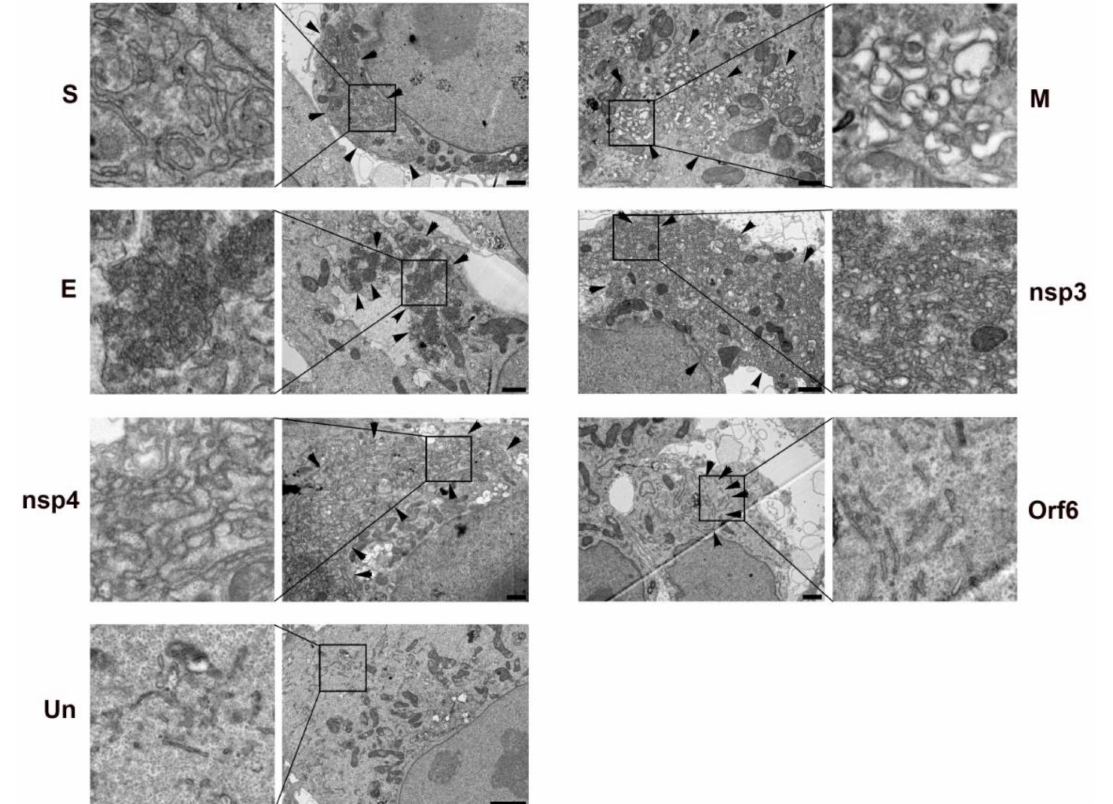
Figure 10. Correlative Light and Electron Microscopy (CLEM) to examine the ultrastructure of transfected cells expression Table 2. E, M, S, Orf6, nsp3, or nsp4 proteins. Transfected cells were immunolabeled with an anti-Strep tag antibody and DyLight 488 secondary antibody. Transfected cells were identified, localized and selected for processing for TEM. Selected cells are shown in Supplementary Figure S4. Each of the six viral proteins induces a unique change in cellular membrane structure. An un-transfected cell (Un) is shown for comparison. Arrowheads indicate regions enriched in SARS-CoV-2 protein induced membrane reorganization. Delineated regions of interest in the transfected cells are enlarged in the leftmost and rightmost columns to show detail. Bars = 1 µ